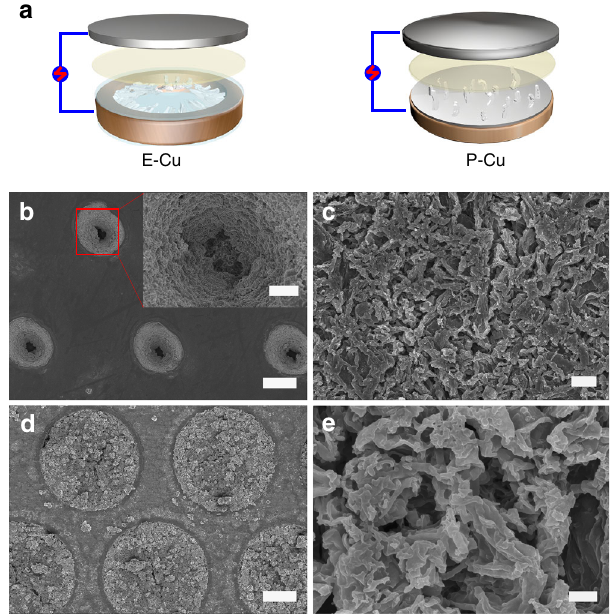
Fig. 5 Morphologies of Li metal anodes after cycling. a Schematic illustration of symmetric cell structure consisting of Li metal electrodes based on E-Cu and P-Cu with a Li metal foil counter electrode. b Surface top-view SEM image of E-Cu after cycling for 150 cycles at 0.5 mA cm − 2 ; the inset is the magni fi ed image of the edge of the pinholes in the PI fi lm from the selected area in a . c Overview SEM image of P-Cu after cycling. d Overview SEM image of E-Cu after peeling off the upper PI fi lm. e Magni fi ed overview SEM image of P-Cu after cycling. The scale bars in b , c , d and e are 50 μ m, 2 μ m, 50 μ m and 500 nm, respectively. The scale bar in the inset